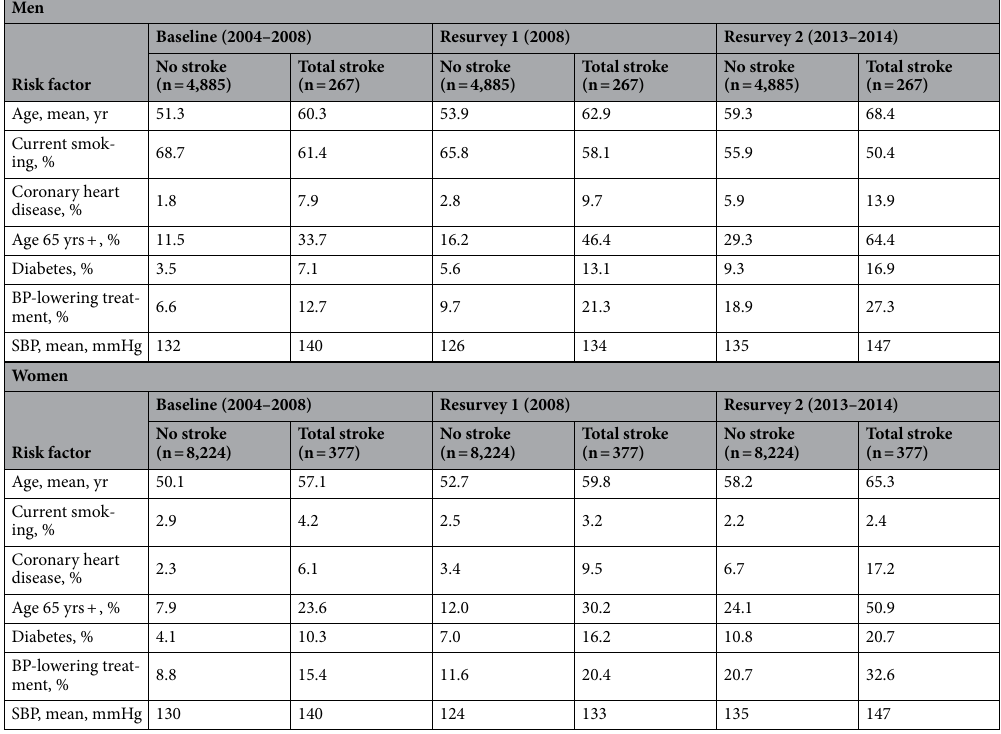
individuals who remained stroke-free until being censored, even if lost to follow up before 3